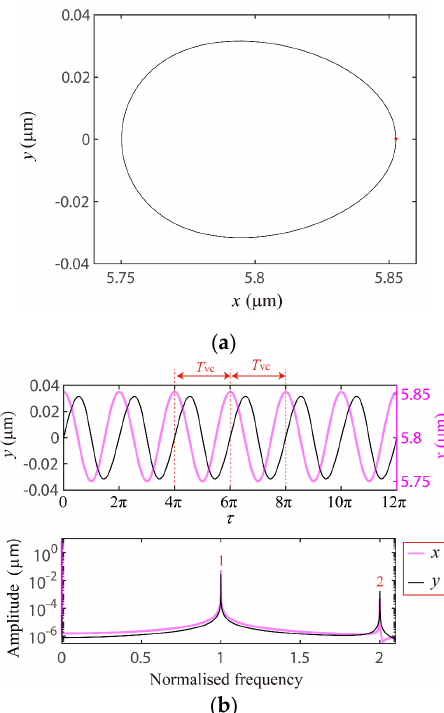
Figure 4. For δ 0 = 1.5 µ m, response characteristics of the VC period-1 motion when Ω = 310 rad / s, ( a ) orbit (black line) and its Poincare mapping (red dots), ( b ) time series and their frequency